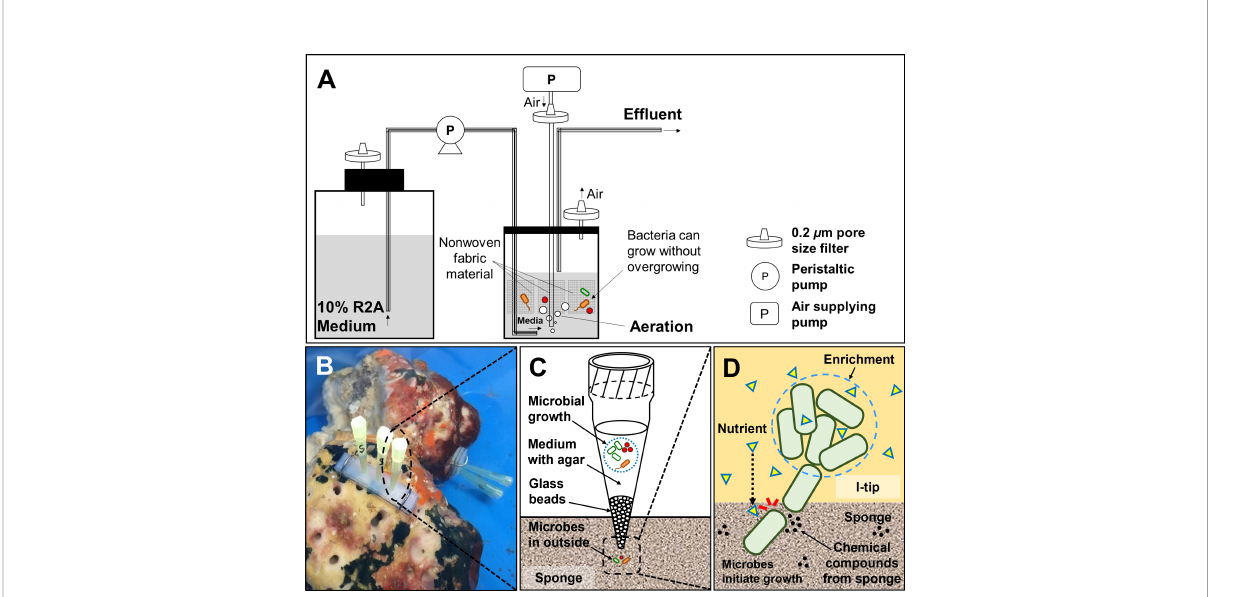
FIGURE 2 Structure and principle of CF (continuous- fl ow bioreactor) cultivation (A) . Schematic showing the in situ view (B) , structure (C) and principle (D) of I-tip.